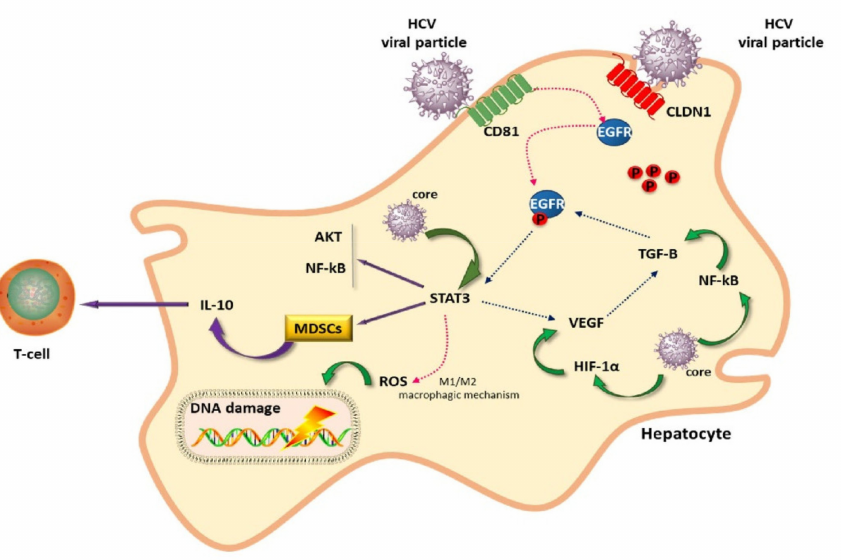
Figure 1. HCV liver cell infection: in this picture a representation of the complex interactions between HCV and cell machinery with involvement of intracellular